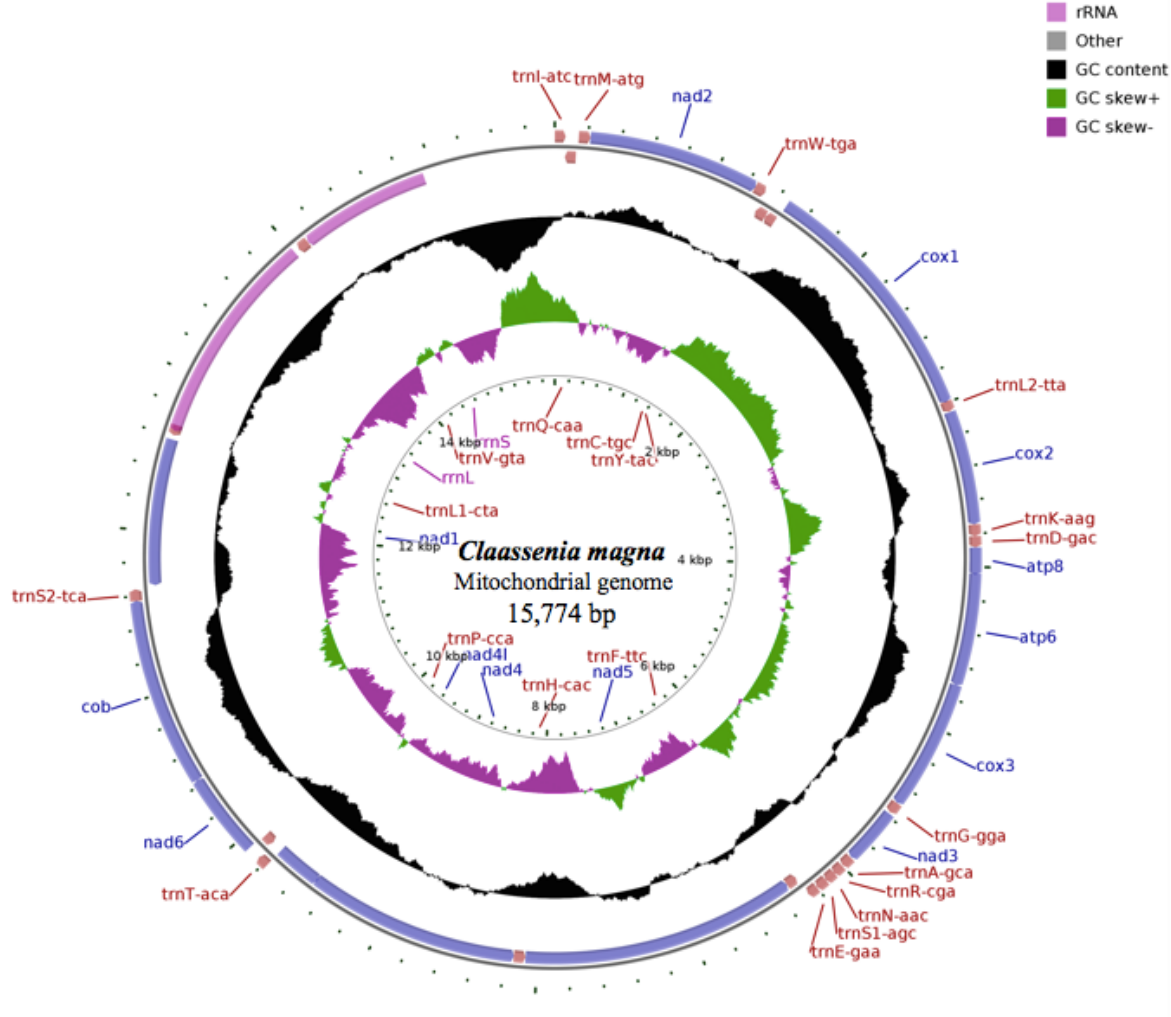
Figure 1. Mitochondrial maps of C. magna . Genes outside the map are transcribed clockwise, whereas genes inside the map are transcribed counterclockwise. The interior circles show GC content and the GC skew, and these are plotted as the deviation from the average value of the entire sequence.